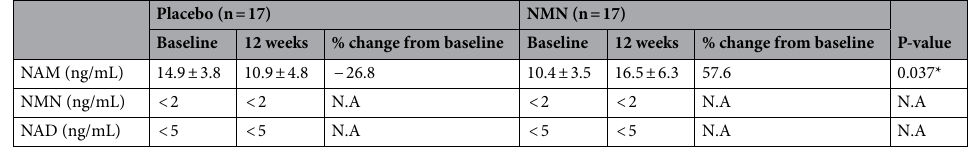
intake group were significantly increased after the intervention compared to the placebo group ( p = 0.037). In addition, an intra-group comparison before and after the intervention revealed that serum NAM in the NMN group significantly increased after 12 weeks ( p = 0.006), while that in the placebo group significantly decreased after intervention ( p = 0.014). On the other hand, NAD + and NMN in the serum were detectable in both groups, but the values were below the lower limit of quantification. Therefore, it was difficult to compare these two parameters between the groups. NAD + -consuming enzymes such as SIRTs and PARPs hydrolyze NAD + to pro- duce NAM and ADP-ribosyl products 2 . Thus, the increased NAM levels by NMN intervention indicate that NMN supplementation effectively enhanced NAD + metabolism in middle-aged adults. Measurement of indicators related to blood vessel condition. We evaluated the effects of NMN supplementation on the conditions of blood vessels. In addition to biochemical and hematological tests, we measured the ankle-brachial index (ABI) and brachial-ankle pulse wave velocity (baPWV) to evaluate blood flow and arterial stiffness, respectively. There were no characteristic clinical findings in the blood pressure, num- ber of blood cells, and ABI values in both groups (Tables 2 and 4). The average baPWV values in the NMN intake group tended to decrease by 25.1 ± 14.5 cm/s (Fig. 2). However, no significant difference was observed in the average baPWV values between the two groups ( p = 0.097). Since hypertension, obesity, and hyperglycemia are considered cardiovascular risk factors, we performed subgroup analyses of NMN and placebo groups in subjects with above-average blood pressure, body mass index (BMI), or blood glucose level. In the analyses of subjects with higher-than-mean systolic or diastolic blood pres- sure, there was no significant change in baPWV values between the groups during the test period (Fig. 3A,B). In contrast, in subjects with above-average BMI or blood glucose levels, baPWV values in the NMN intake group were significantly decreased after the test period compared to the placebo group (Fig. 3C,D). These results sug- gest that NMN supplementation potentially improves vascular health in middle-aged adults, especially in those with high BMI or blood glucose levels. Measurements of other health parameters. We assessed the effects of NMN administration on three between the two groups (Table 5).